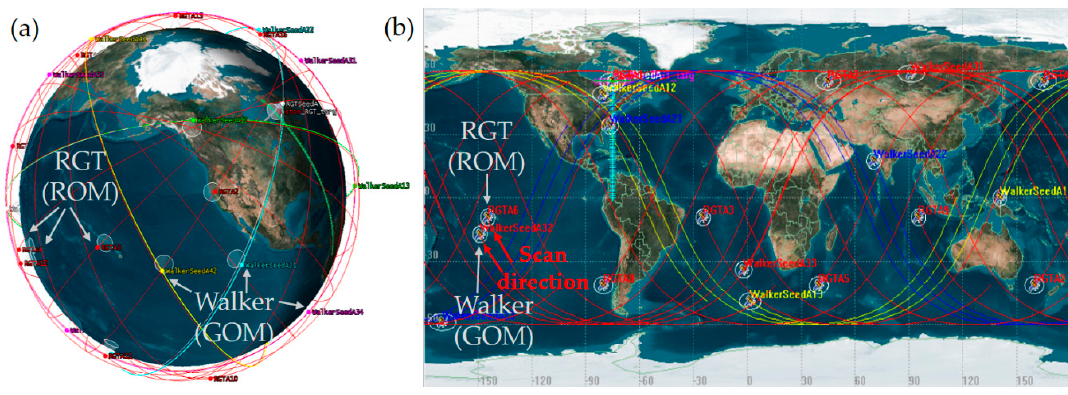
Figure 4. ReCon simulations: ( a ) 3D view; ( b ) 2D view.